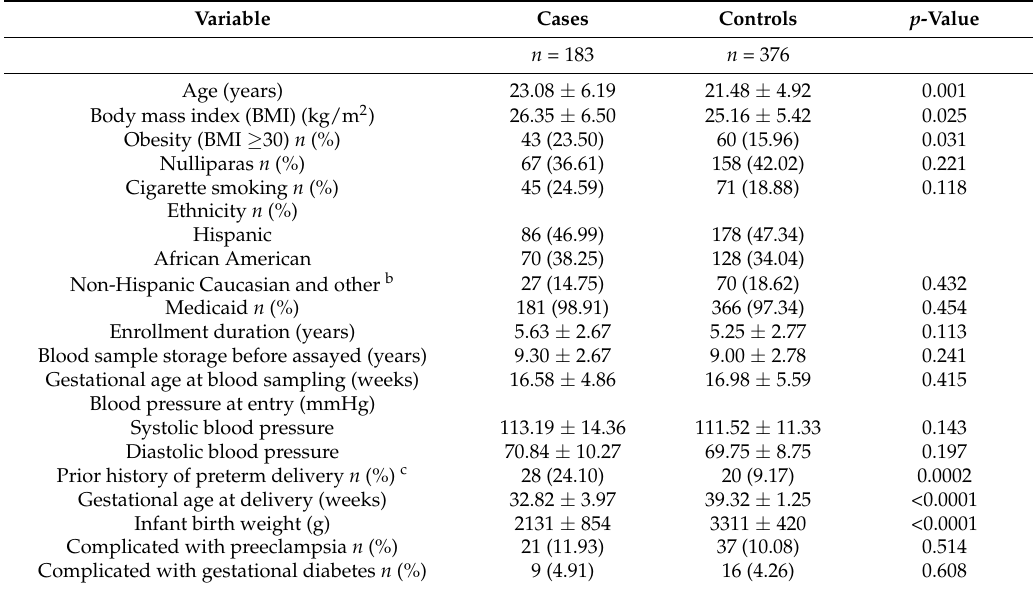
Table 1. Clinical characteristics of spontaneous preterm delivery cases and term controls a .